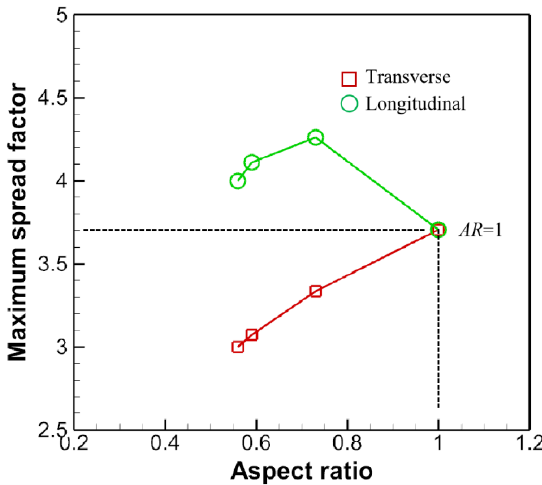
Figure 16. Maximum spread factors for different ARs for the oblate drop impact.